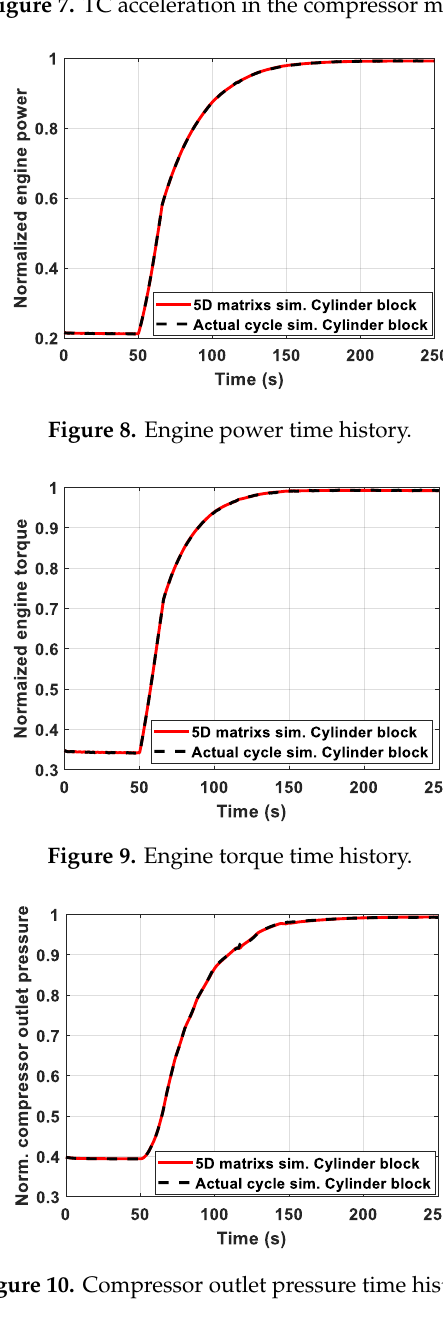
Figure 11. Compressor air flow rate time history. Figure 12. Turbine inlet pressure time history.